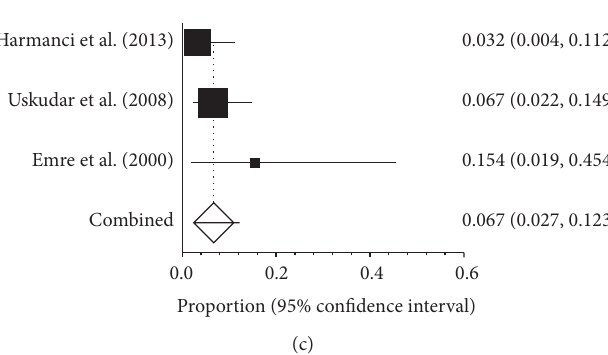
V Leiden mutation (12.0%) in BCS [3]. Therefore, pregnancy must not be neglected as the etiology of BCS is being